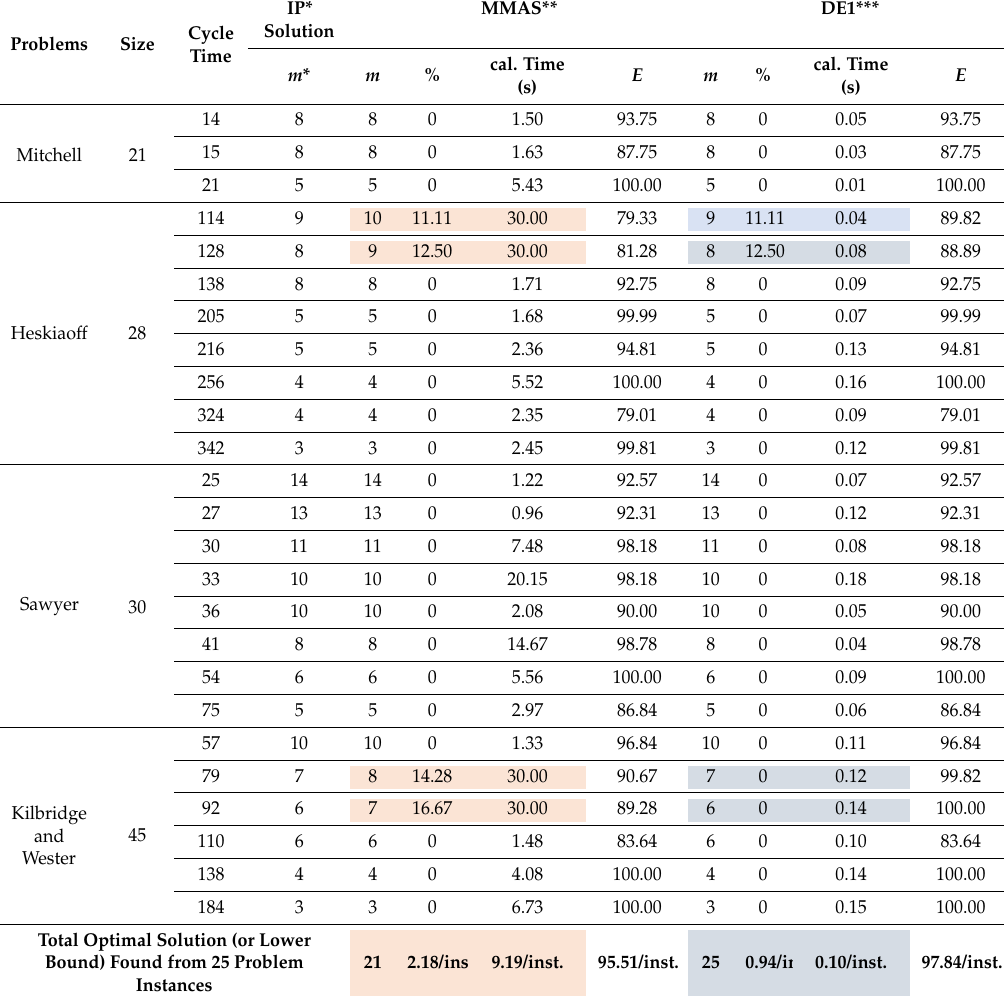
Table 6. The Results of Using the Proposed DE Compared with Using MMAS (No Local Search)